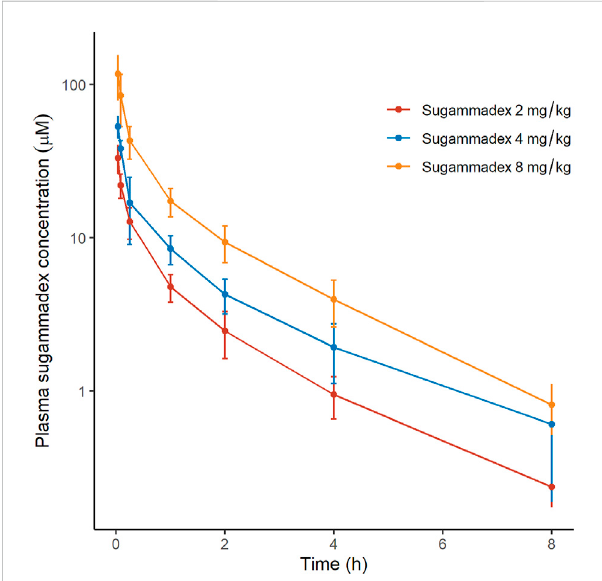
FIGURE 4 Plasma concentrations of sugammadex as a function of elapsed time after rocuronium administration, discriminated by allocated group.The y -axisislogarithmicallyscaled,andtheerrorbarsrepresent standard